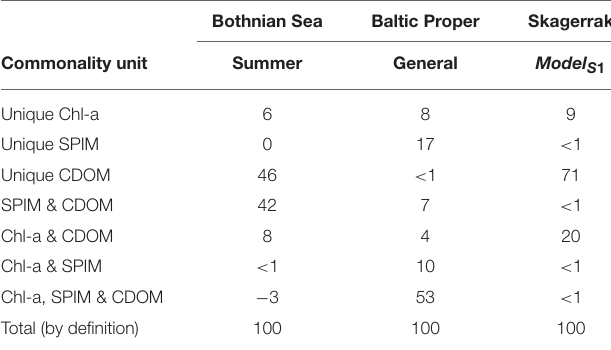
TABLE 4 | Results of the commonality analysis, showing the percentage of contribution to the explained variations to the R 2 adj for the main Z SD models in the three